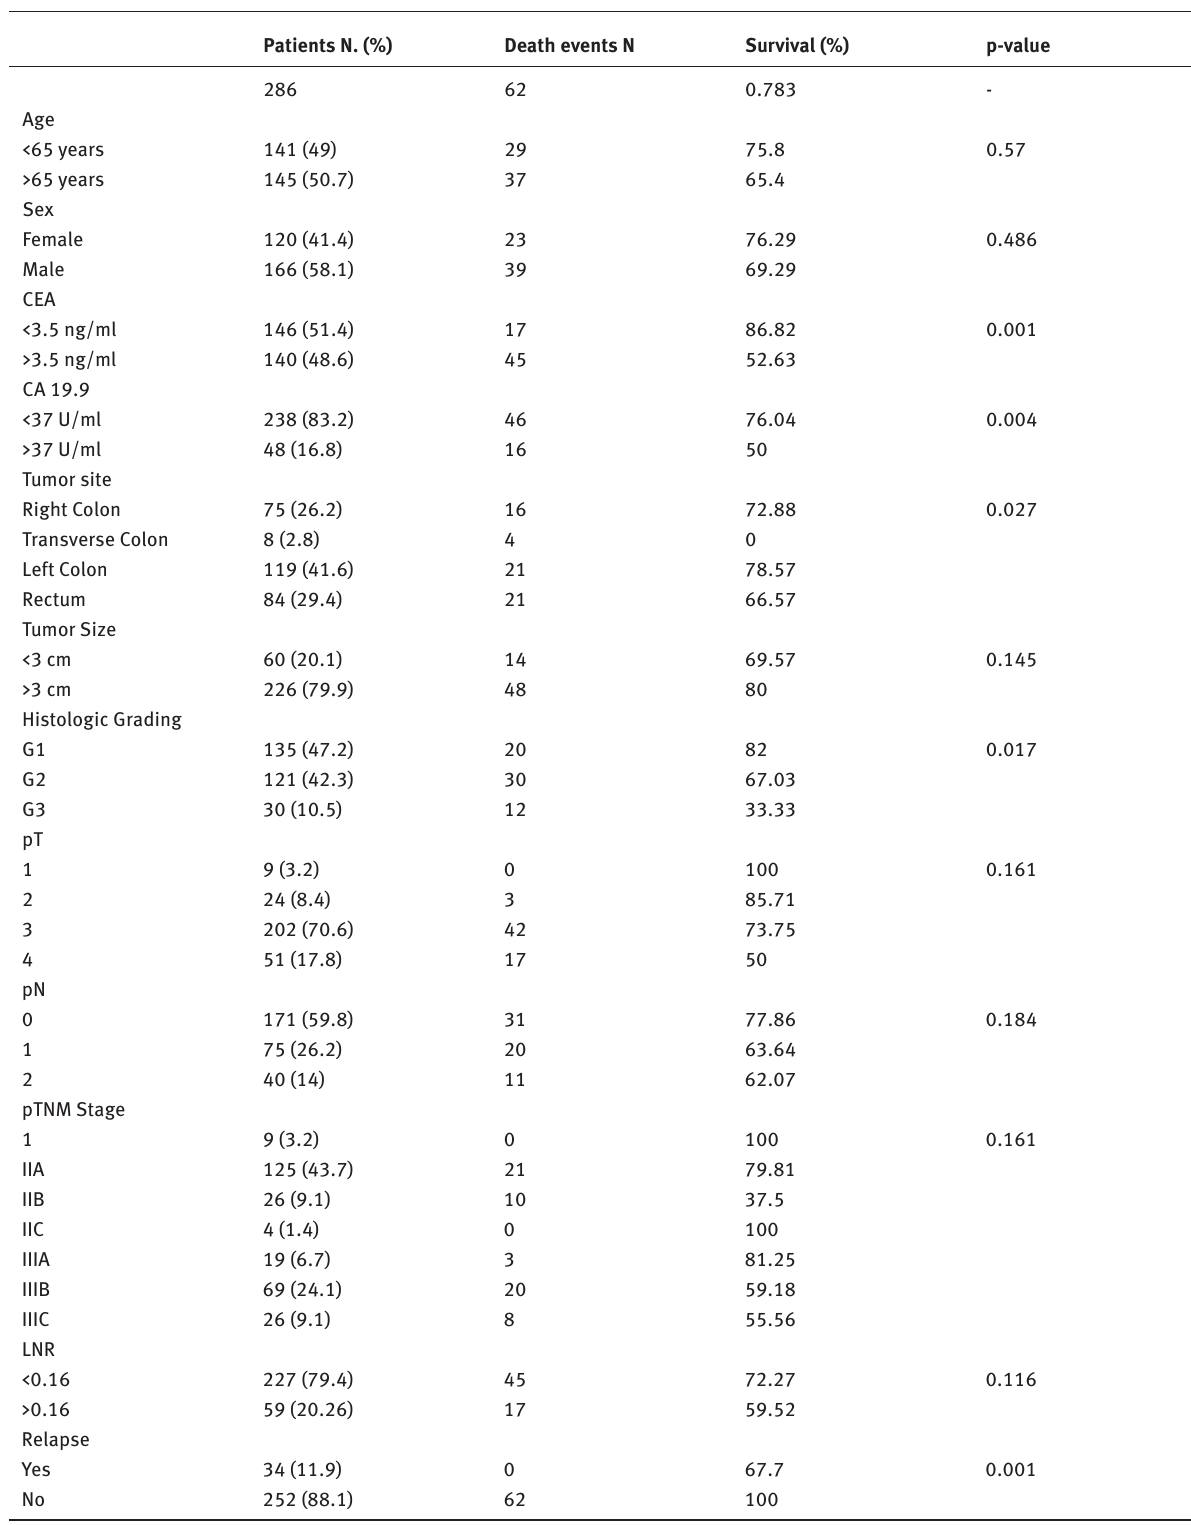
Table 1: Clinico-pathological features and univariate analysis of overall survival in colorectal cancer patients who underwent potentially curative